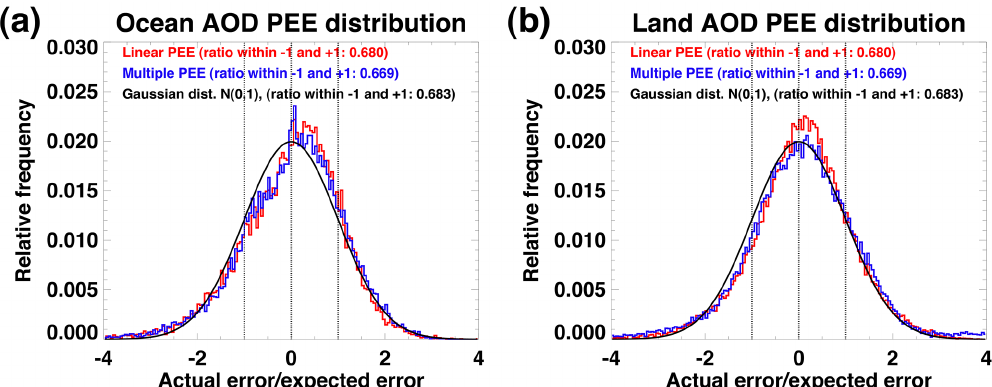
Figure 11. Comparison of observed (a) ocean and (b) land AOD error distributions with theoretical Gaussian distributions for the linear PEE (red) and multiple PEE